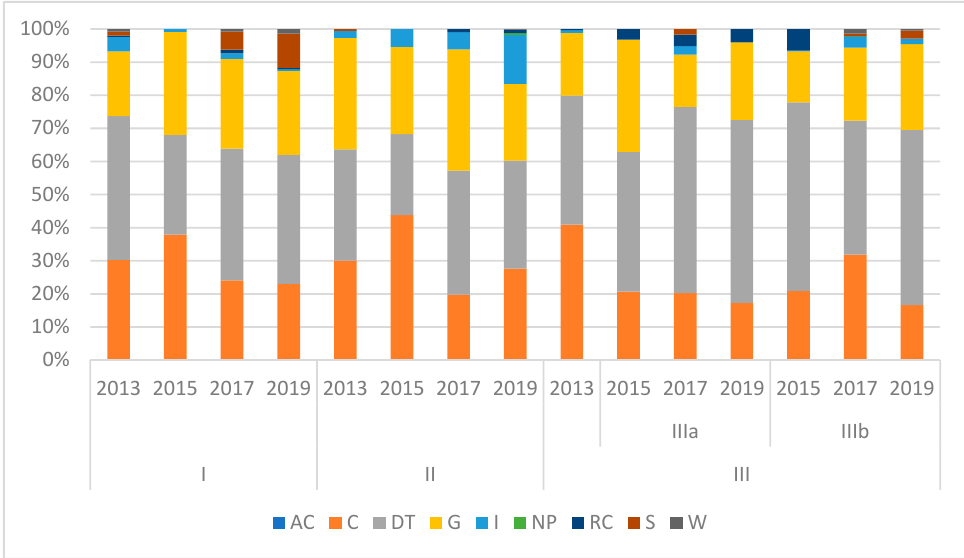
Figure 1. Distribution of social behavior types (SBT) of the taxa in the areas. AC: adventive competitors; C: competitors; DT: disturbance-tolerants; G: generalists; I: invasives; NP: natural pioneers; RC: ruderal competitors; S: specialists; W: weed.